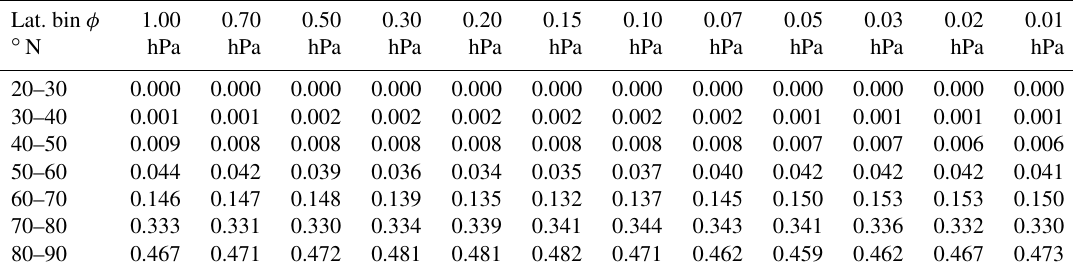
Table A3. Normalized latitudinal distribution (cid:57)(φ,z) of EPP-NO y densities and fluxes during ES episodes as a function of pressure level. Lat. bin